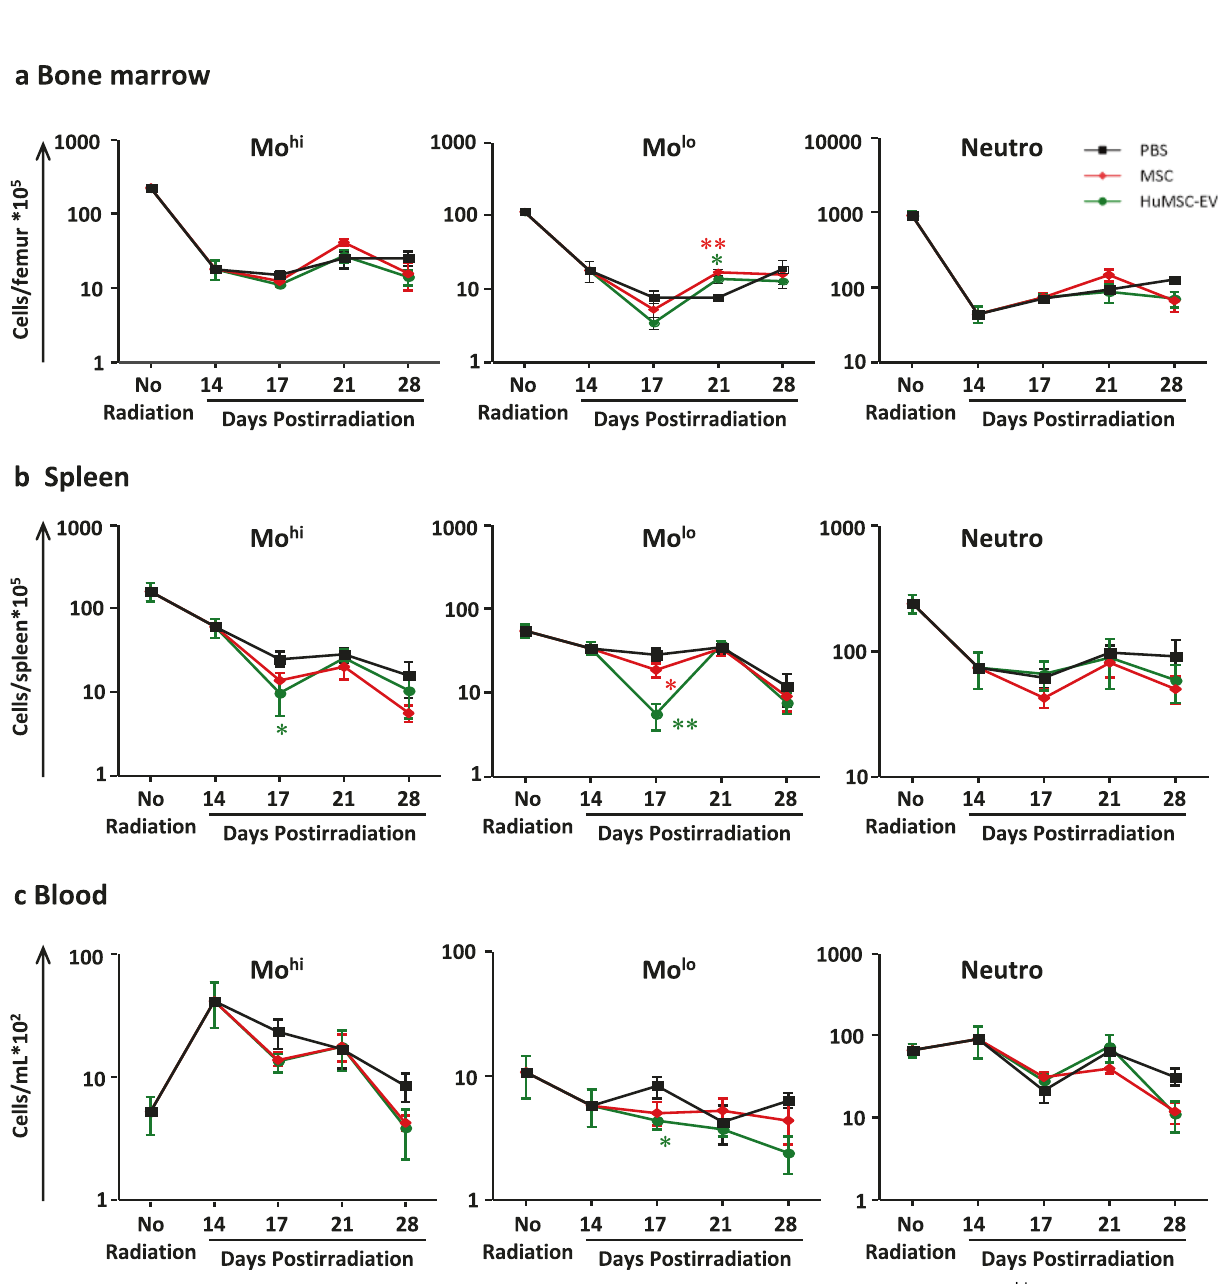
Fig. 3 HuMSC-EV induce monocyte mobilization from BM and spleen. Quantitative analysis of cell counts for Mo hi (CD11bLy6G – 7/4hi) (left), Mo lo (CD11bLy6G – 7/4lo) (middle), gated on CD45 + , CD11b + cells, and neutrophils (CD11b + Ly6G + 7/4hi) (right) in BM ( a ), spleen ( b ) and blood ( c ) at days 14, 17, 21 and 28 post-irradiation. Data are means ± SEM ( n = 5 – 6 animals/group); * P < 0.05, ** P < 0.01 between HuMSC-EV and PBS; one-way ANOVA followed by Tukey ’ s test.